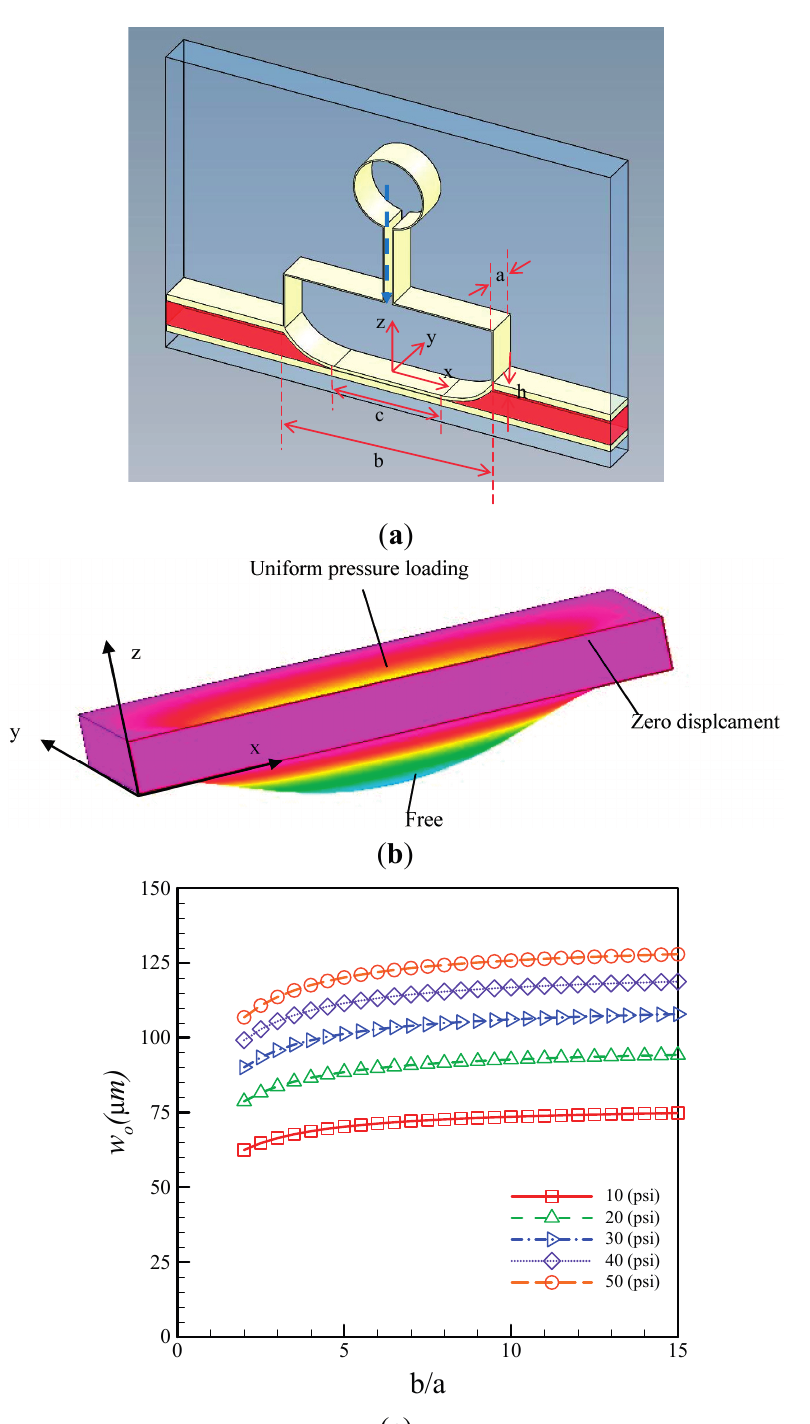
Figure 4. ( a ) Schematic illustration of the flexible membrane, side chamber, and microchannel; ( b ) The boundary conditions of 3-D numerical simulation for the larger deformation; ( c ) Deformed profiles of flexible membrane related with the axial/transversal length ( b / a ) ratio under different air